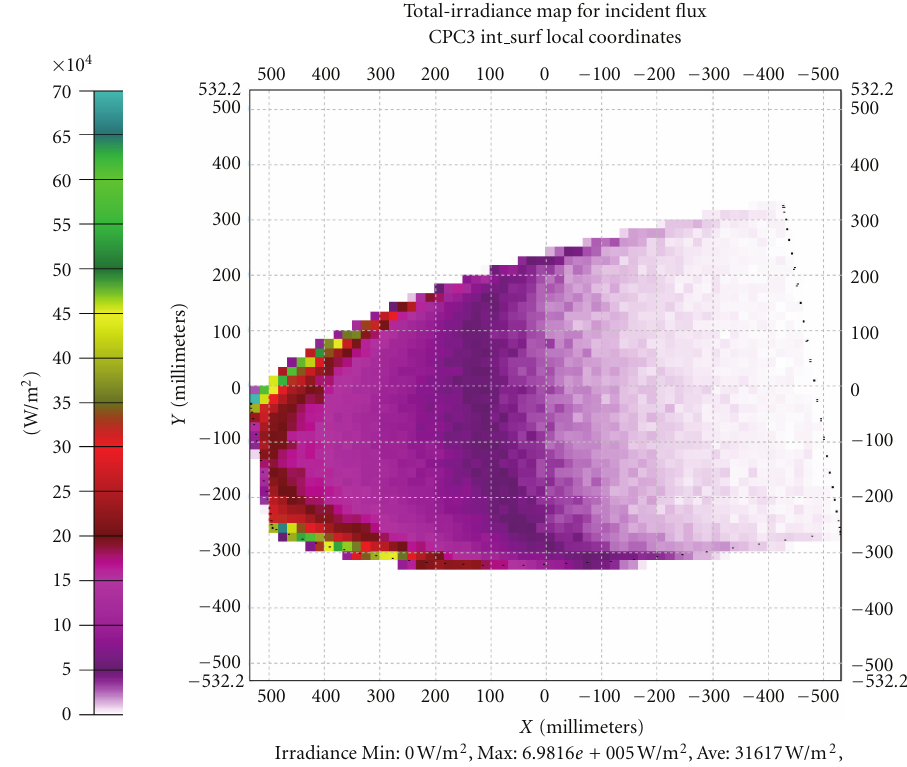
Figure 3: Projected irradiance map of the ideal CPC.